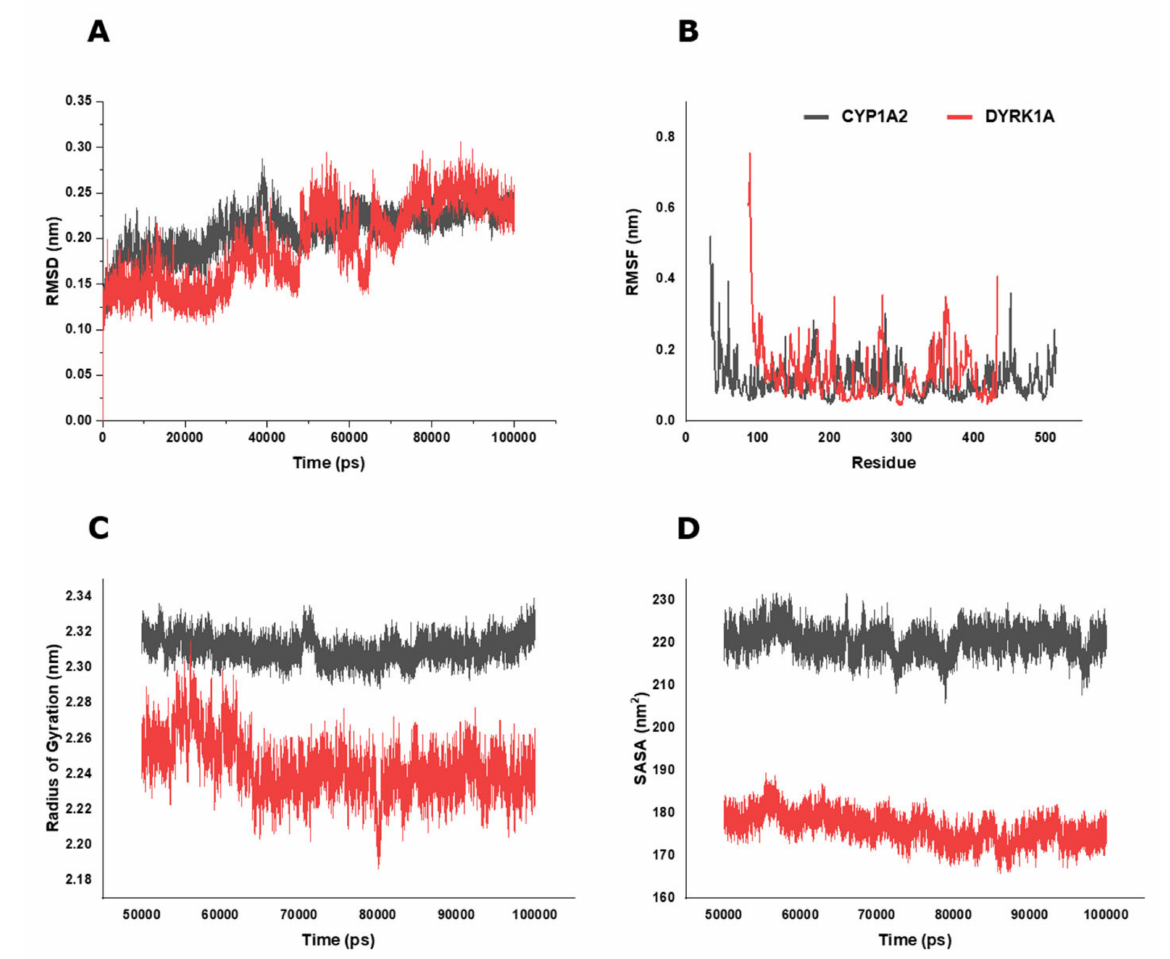
Figure 9. Molecular simulation dynamics of CYP1A2 (Grey) and DYRK1A (Red) protein and com- pound BP. ( A ) Plot of time vs. RMSD of CYP1A2 and DYRK1A protein relative to the starting complexes during 10000 ps MD test for compound BP. ( B ) RMSF plot of CYP1A2 (Grey) and DYRK1A (Red) protein during 10,000 ps MD represents local changes along the protein chain. ( C ) Radius of gyration (Rg) value and ( D ) solvent-accessible surface area (SASA) plot value during the computed 10,000 ps of time for all the